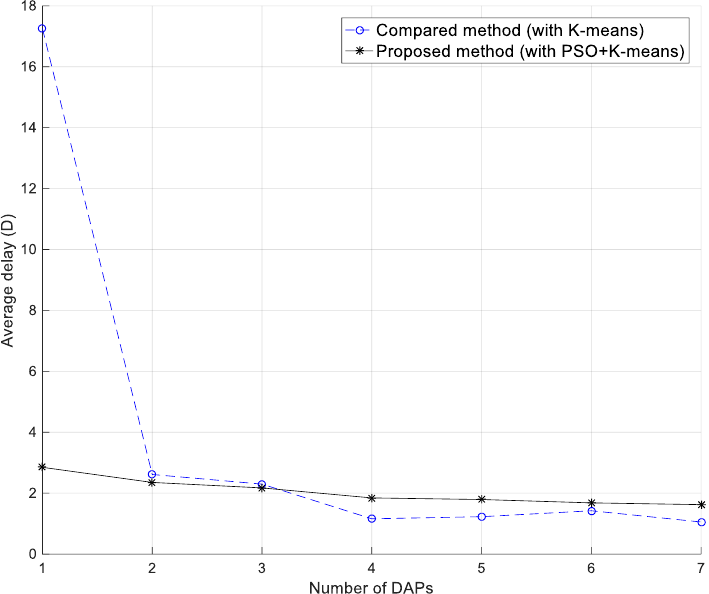
Figure 12. The relationships of average delay ( D ) in cases of different numbers of DAPs.